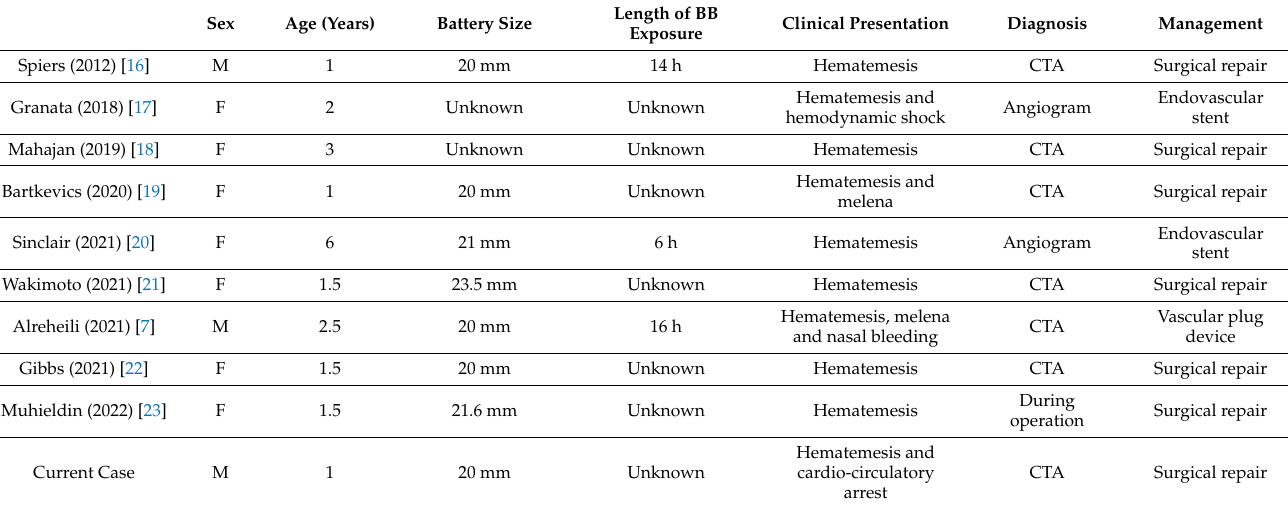
Table 1. Survival cases of BBI complicated by aorto-esophageal